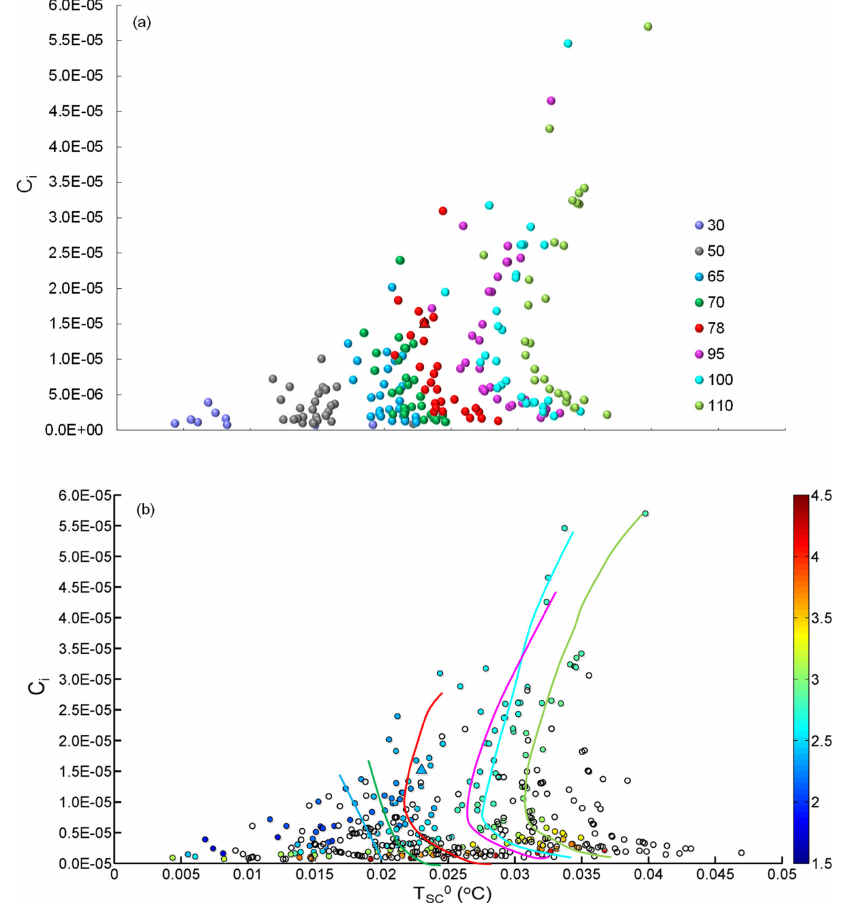
Figure 9. Same as Fig. 7 but for the relationship between T 0